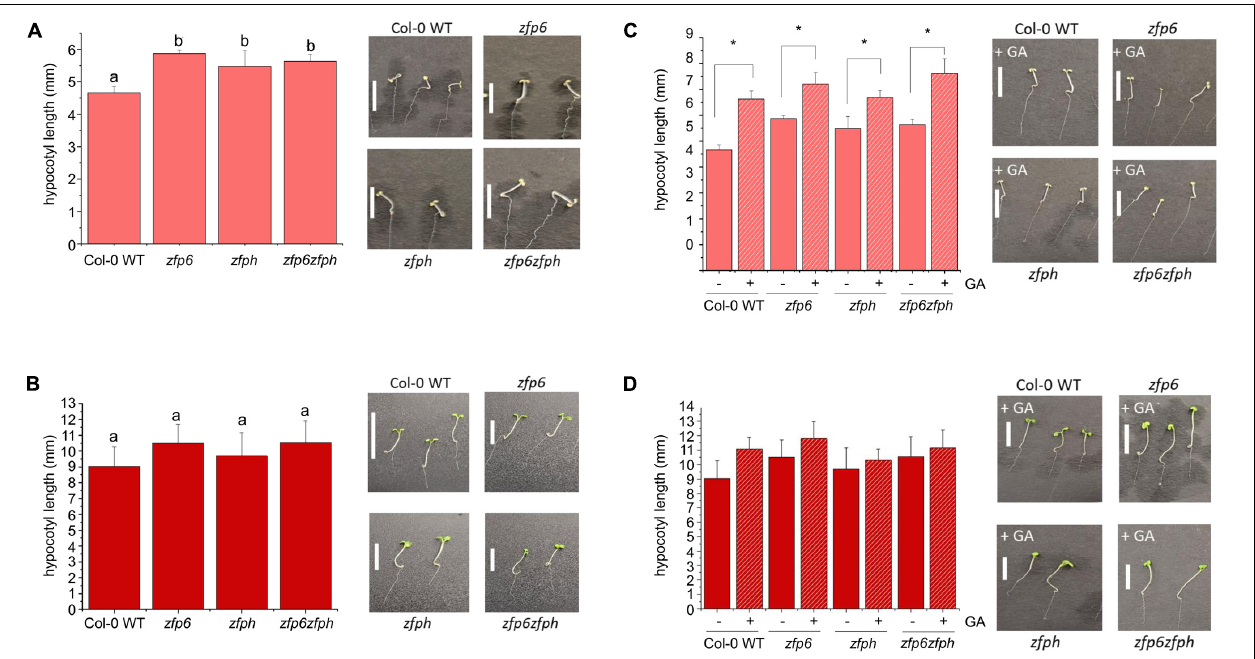
FIGURE 3 | Hypocotyl measurements in FR and R light-exposed seedlings. Seedlings were stratified at 4 ◦ C for 4 days in dark on MS plates with 1% sucrose, and subsequently incubated in continuous far-red FR light or R light for 7 days at 22 ◦ C. (A,B) Untreated seedlings on MS plates exposed to (A) FR or (B) R light. (C,D) Seedlings on MS plates with (+) or without (–) the addition of 10 µ M GA under (C) FR or (D) R light. Hypocotyl measurements were performed using Photoshop 2021 with 3 plates per treatment, each containing 10 seedlings ( n = 30). Significant differences are highlighted with different letters (A,B) or asterisks (C,D) at p ≤ 0.05. Representative images of seedlings under each condition are shown to the right of bar graphs and the bar in the images equals 1